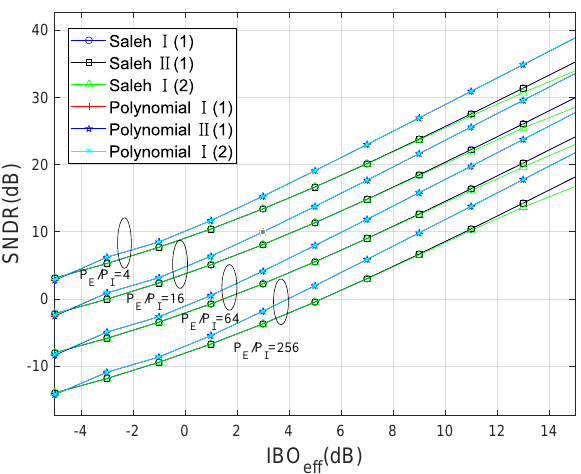
Figure 6. The SNDR as a function of the effective IBO with varying power ratios (Class B PA, Saleh, and polynomial models).